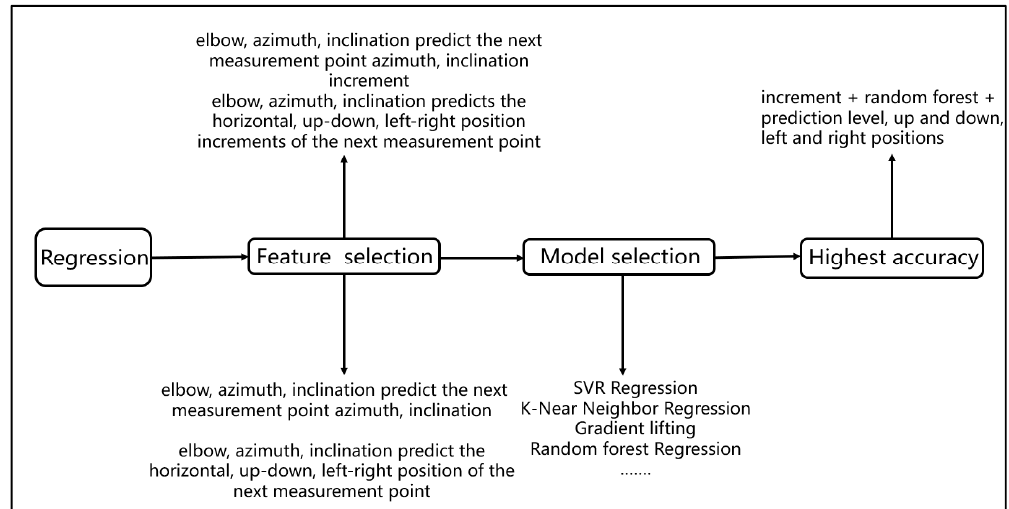
Figure 2. Feature and model selection flowchart.